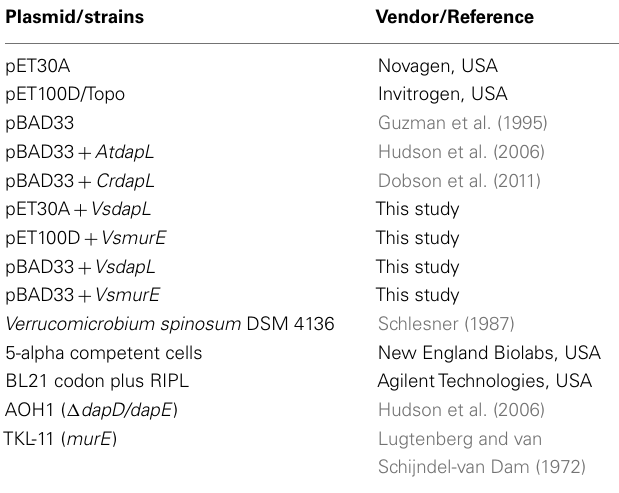
Table 3 | Plasmids and strains used in this study.